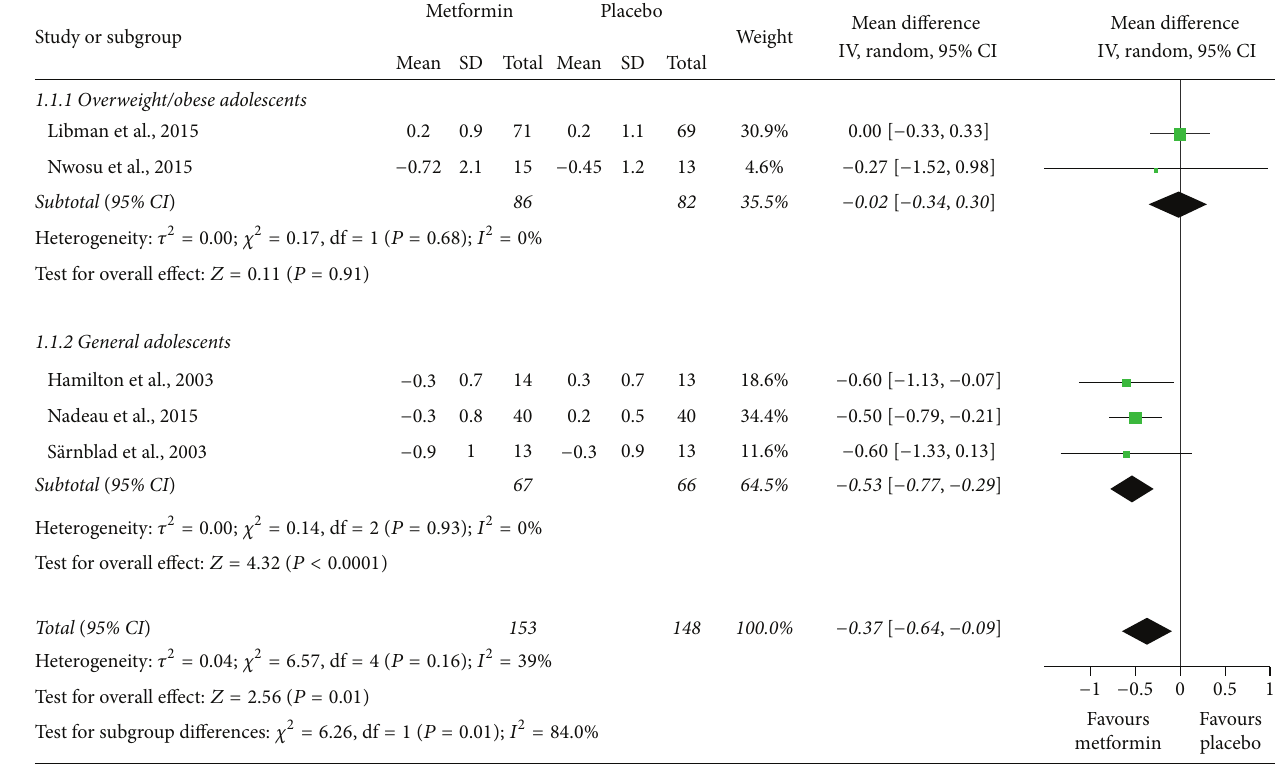
Figure 2: Mean differences in changes in hemoglobin A1c (HbA1c) levels from baseline to study termination between patients who received adjunctive metformin therapy or placebo in adolescents with type 1 diabetes mellitus. CI: confidence interval; IV: inverse